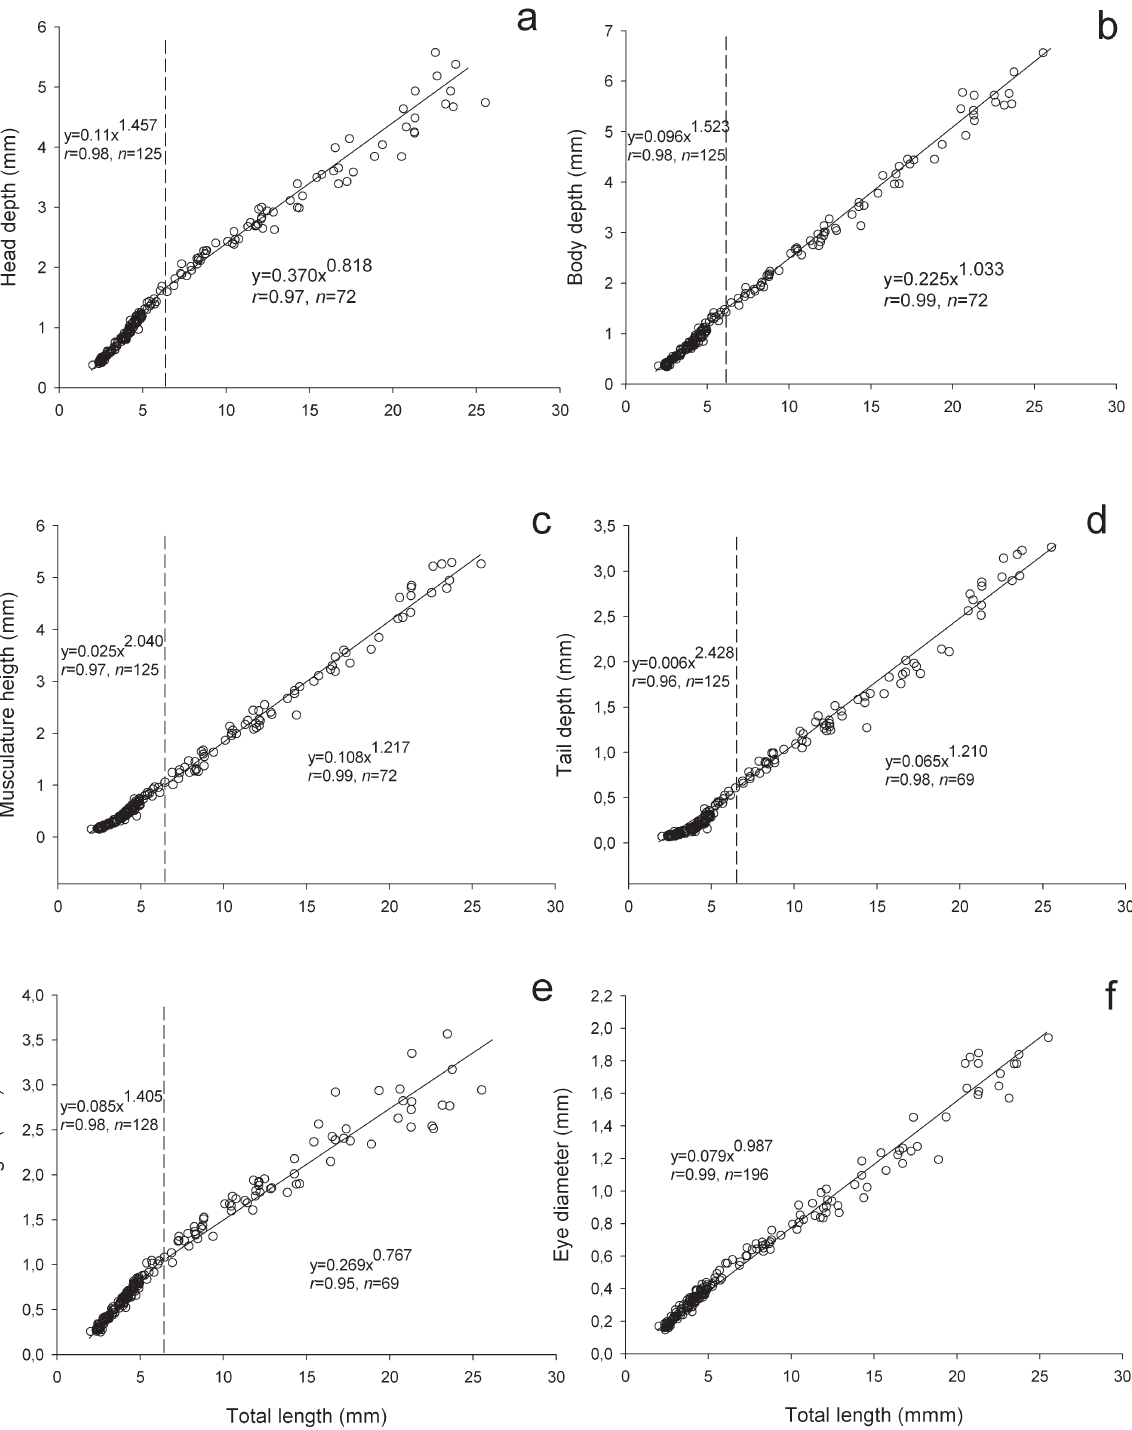
Fig. 5. – Allometric growth equations between measured body proportions and total length during spotted sand bass development. The dashed line represents the inflection point of